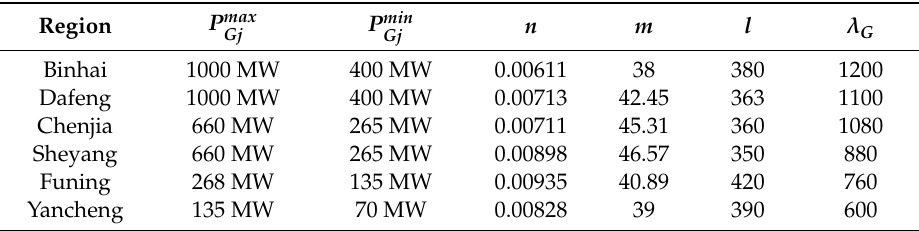
Table 3. Parameters of conventional units.